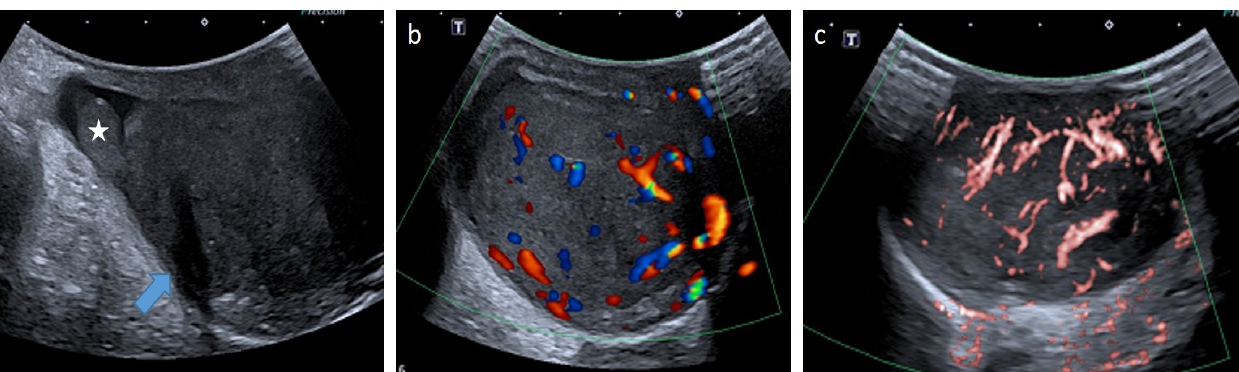
Figure 12. Para-testicular epithelial cyst in a 15-year-old boy. Longitudinal gray-scale B-mode ( a ) and color Doppler ( b ) US of the testis. Images show a small para-testicular cyst (blue arrow) in contact with albuginea. The lesion was removed with a scrotal approach, and pathology revealed a para-testicular epithelial cyst. US, ultrasonography.